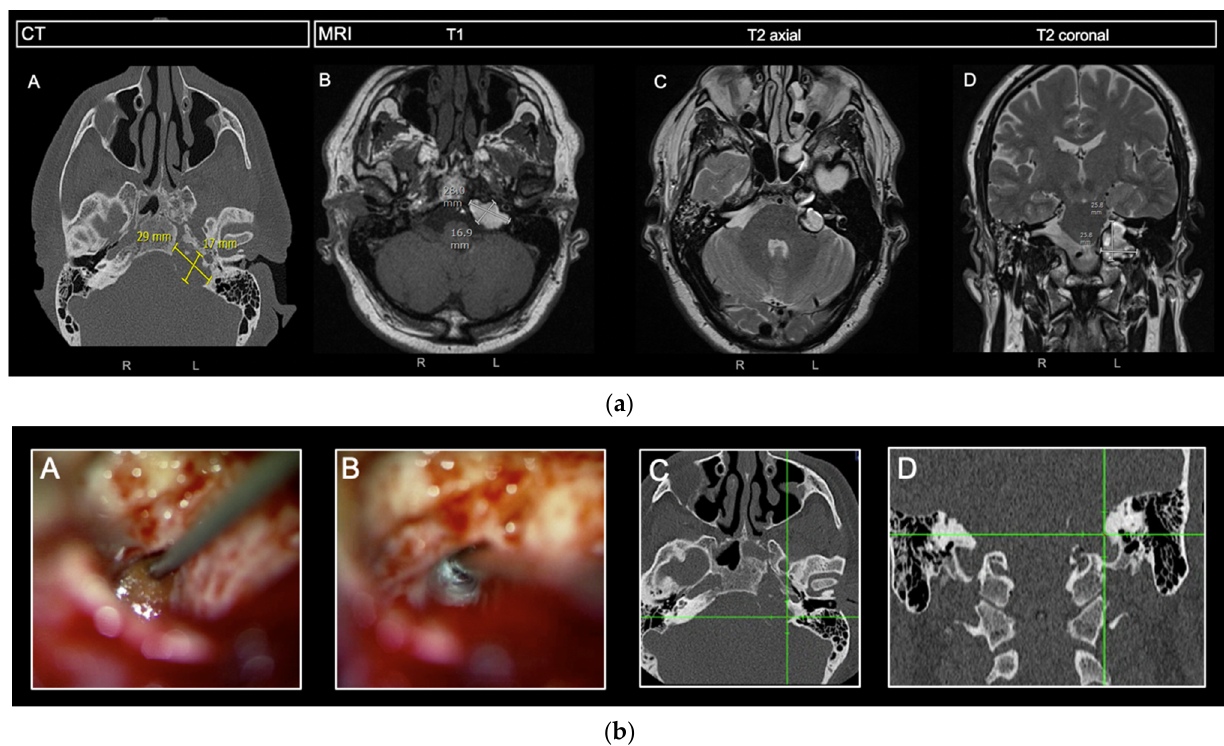
Figure 3. ( a ) Preoperative radiologic findings of a petrous apex cholesterol granuloma on the